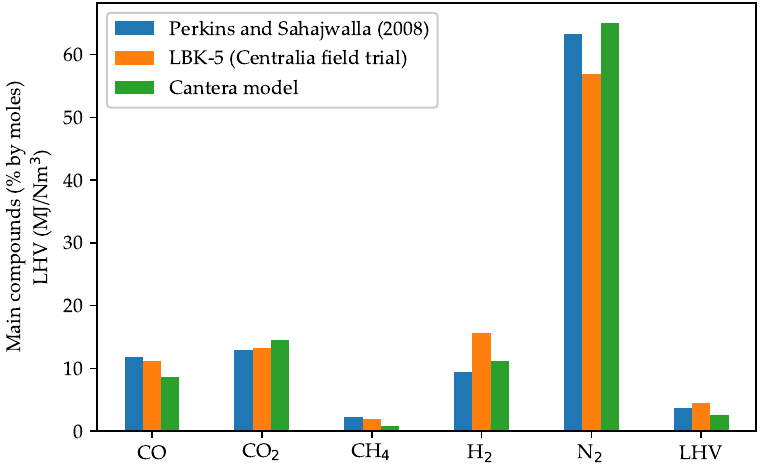
Figure 6. Comparison of our simulation results on the Centralia Large Block experiment LBK-5 (T = 585 ◦ C, p = 0.125 MPa, stoichiometric ratio = 0.3) against field data [58] and the kinetic modeling results of Perkins and Sahajwalla